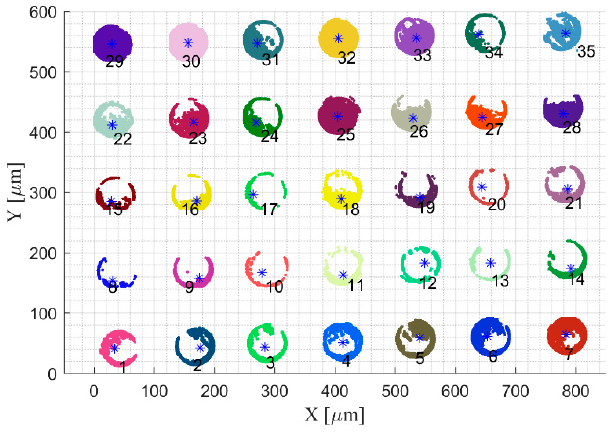
Figure 9. Separation of the cylinders.